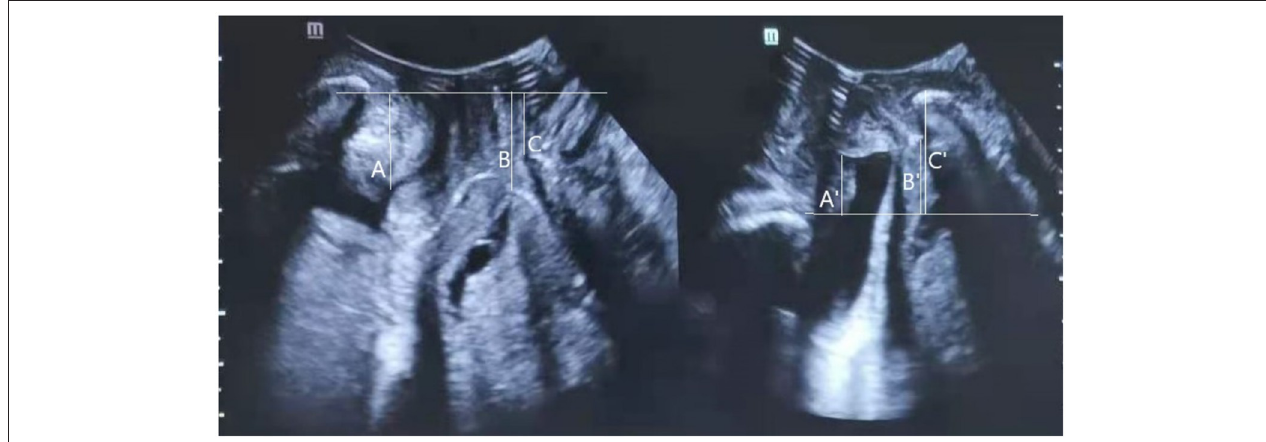
FIGURE 1 | Transperineal ultrasound image in the mid-sagittal plane demonstrating the measurement of the distance between the leading edge of the bladder neck (A at rest; A’ under Valsalva), cervix (B at rest; B’ under Valsalva), or rectal ampulla (C at rest; C’ under Valsalva), and the horizon line at the level of the posterior inferior margin of the pubic symphysis. Measurements cranial to the reference line are positive; those caudal to the line are negative. Bladder neck mobility (BNM), cervix mobility (CM), and rectum ampulla mobility (RAM), were calculated as the absolute difference between rest and Valsalva maneuver in the pubis-bladder neck, pubis-cervix, or pubis-rectum ampulla